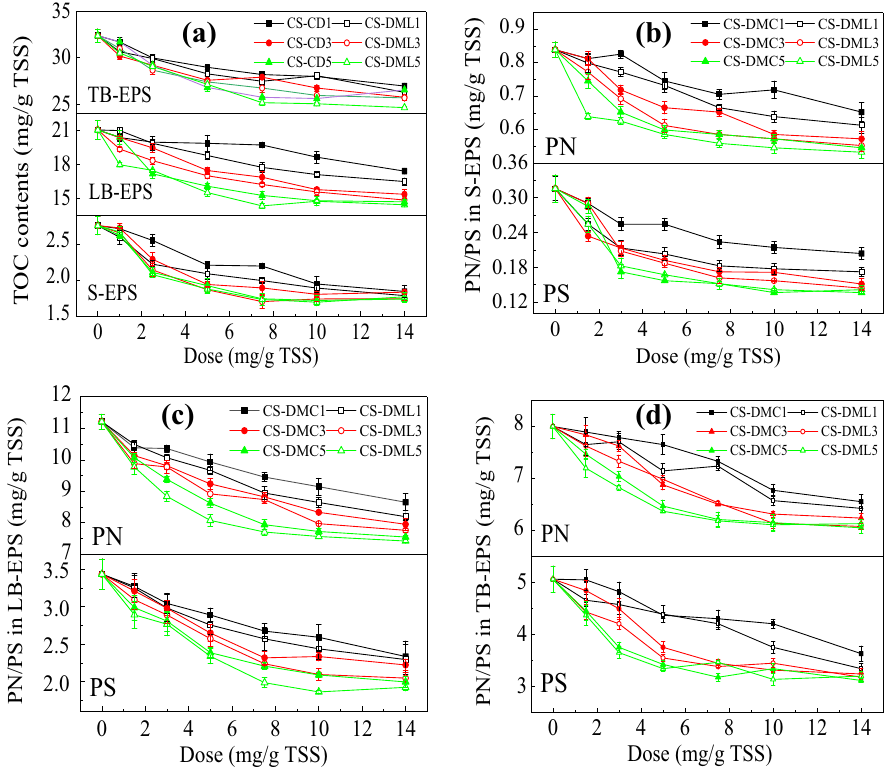
Figure 4. ( a ) TOC content in each of the EPS, PN and PS content of ( b ) S-EPS, ( c ) LB-EPS, and ( d ) TB-EPS in sludge treated by various St-based